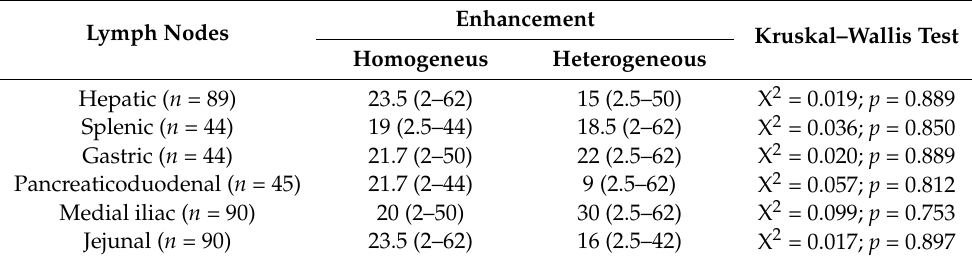
Table 4. Median and range values of BW (kg) according to ALs enhancement stratified according to localization.